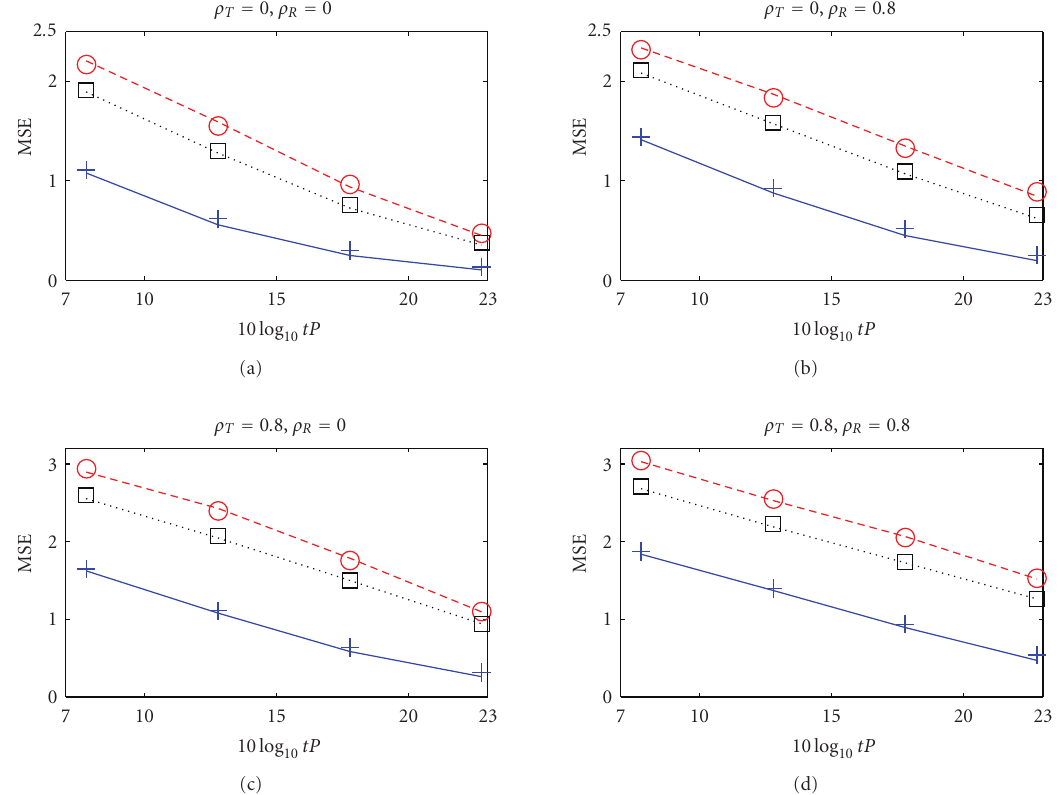
Figure 7: MSE’s as functions of 10log tP under per-antenna and per-cell power constraints for di ff erent values of ρ T and ρ R . System 10 parameters are shown in example 1 of Table 1. ( Legends are the same as in Figure 5.